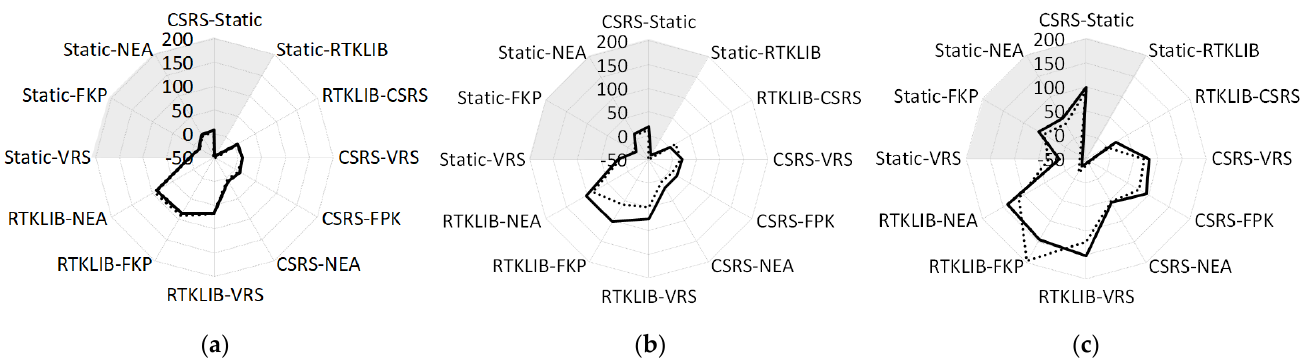
Figure 3. Mean values, μ (mm), of: ( a ) Δ N; ( b ) Δ E; ( c ) Δ h differences, pre and post outliers’ removal (dashed and continuous lines, respectively). Pairs involving static are here highlighted in grey and in figures hereinafter.